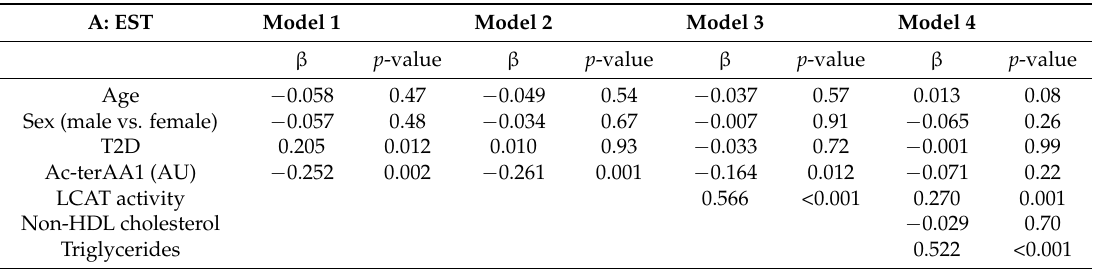
Table 5. Multivariable linear regression analysis showing the association of Ac-terAA1 with